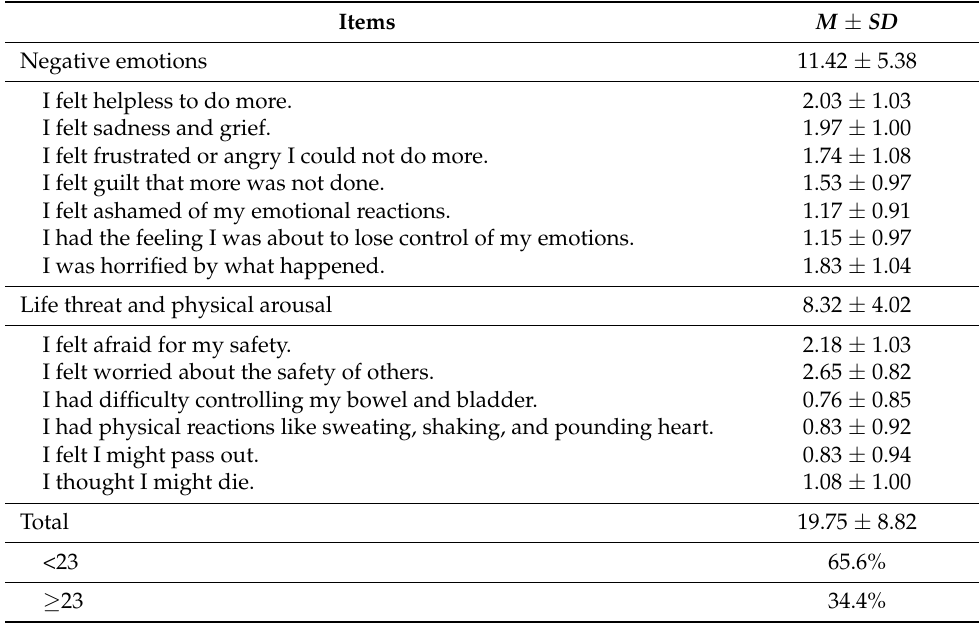
Table 2. Peritraumatic distress ( n =